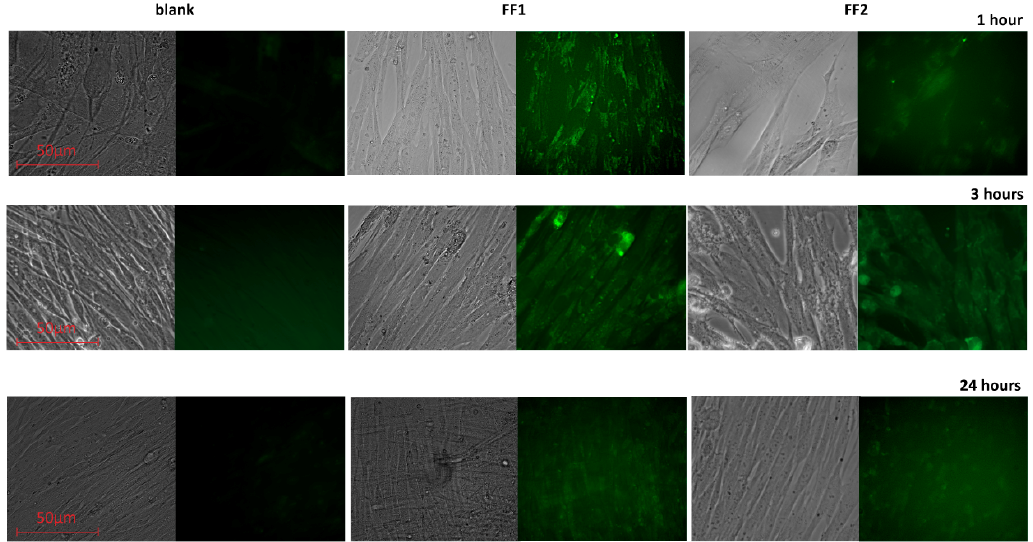
Figure 4. Fluorescence of FF1 (1 μ M) in human fetal lung fibroblasts (HFLF) after 1 h of incubation. ( 1 ) Transmitted light; ( 2 ) fluorescence image detected with a 450–525-nm light filter; ( 3 ) fluorescence image detected with a 600–650-nm filter; excitation wavelength, 370 nm; magnification, × 40.